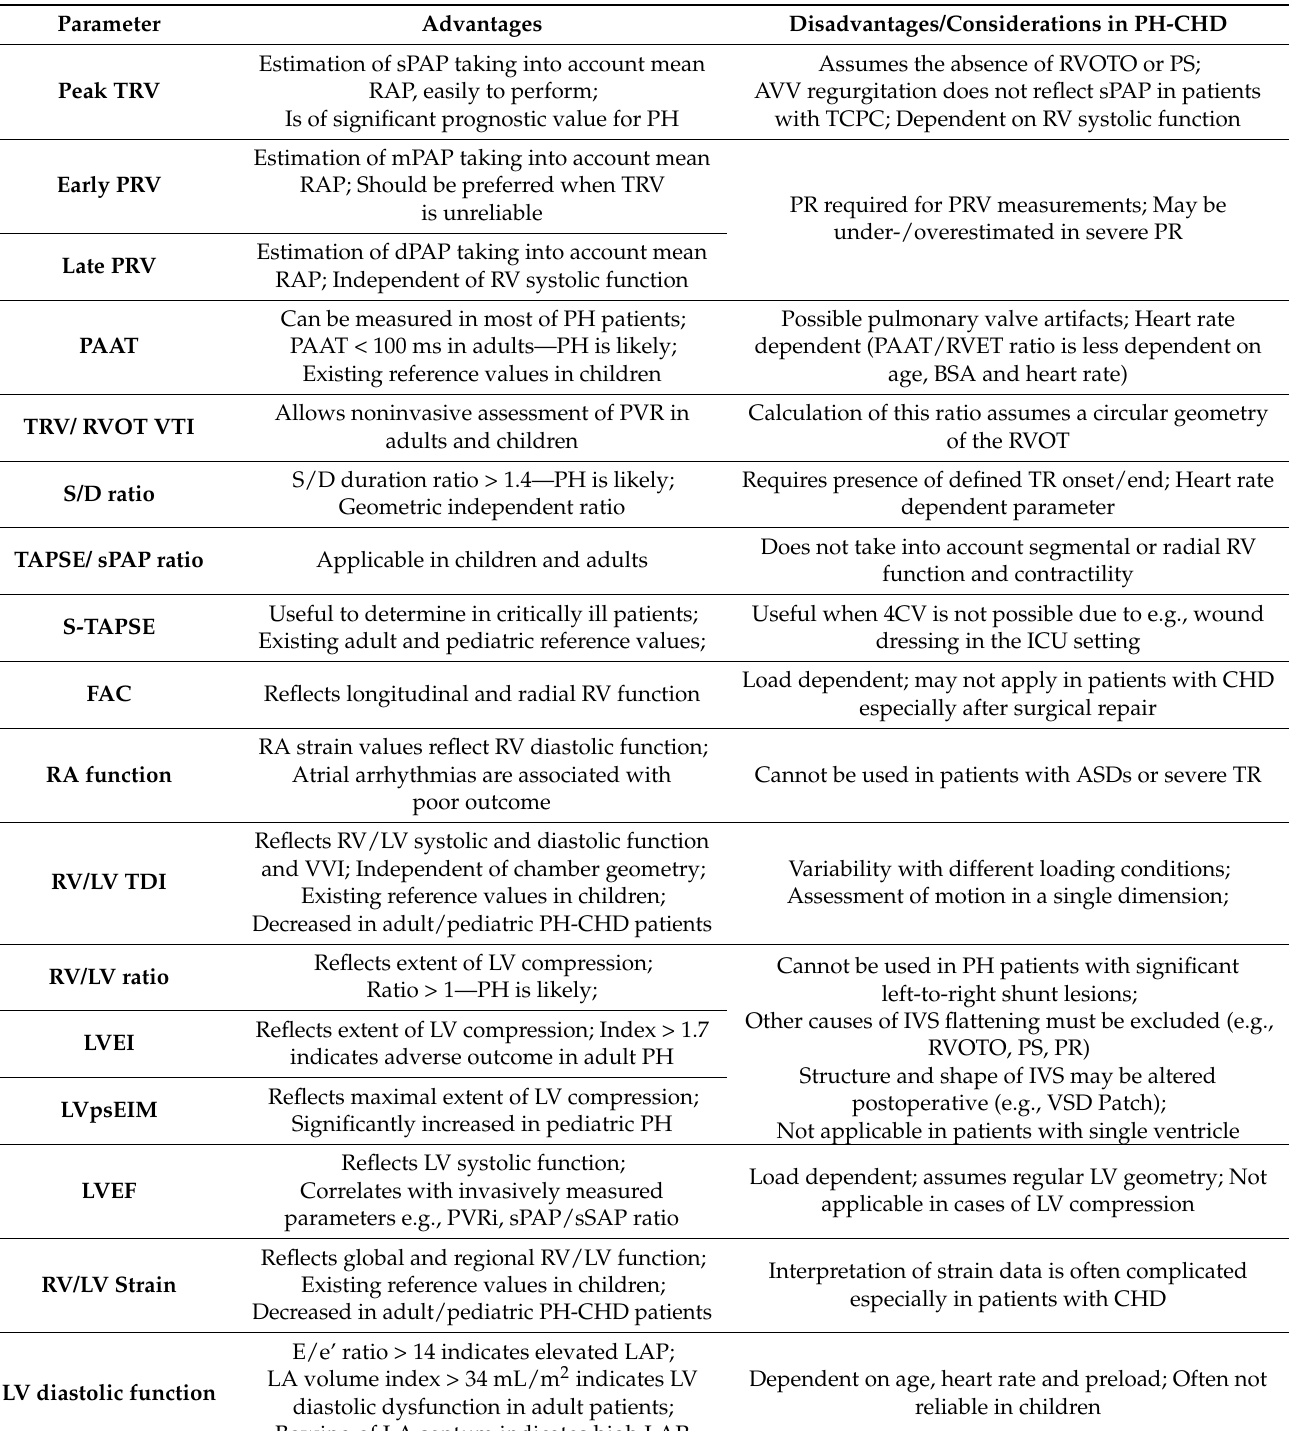
Table 3. Advantages, disadvantages and considerations of echocardiographic measurements in patients with